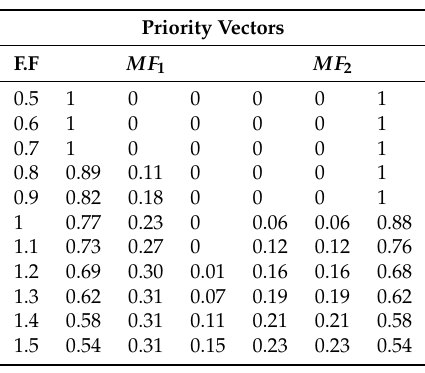
Table 7. Priority vectors for MF 1 and MF 2 .